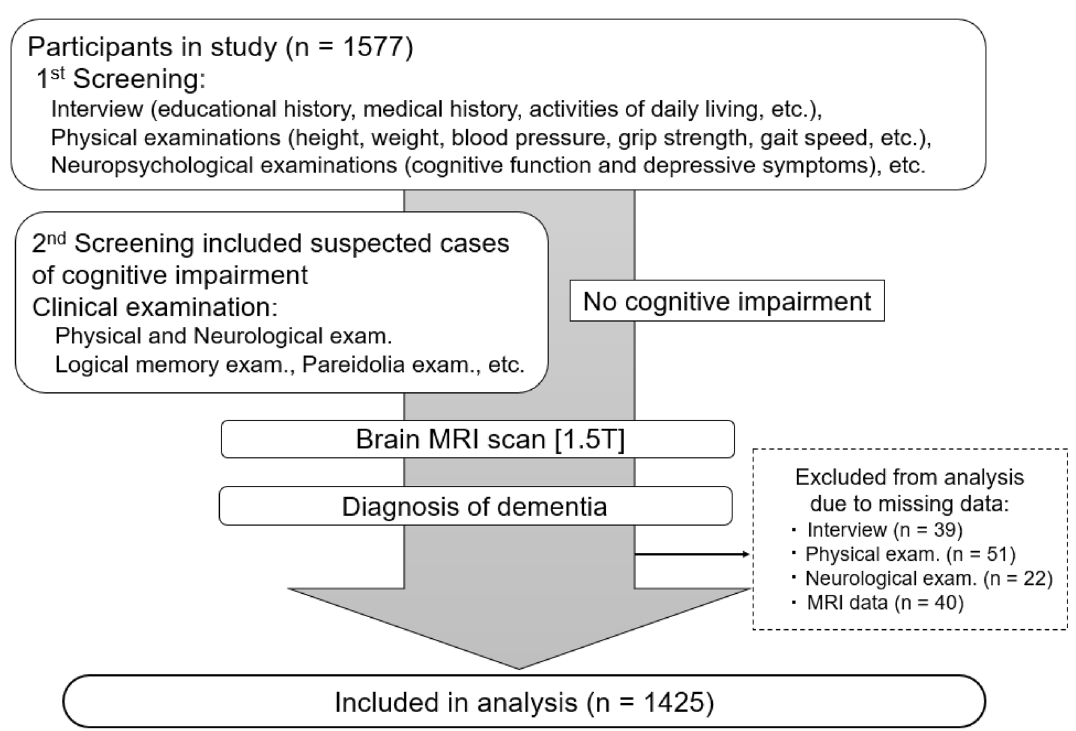
Figure 1. Flow diagram of study enrolment. The population-based cross-sectional data were obtained from one research site (Arao City, Kumamoto Prefecture) of the Japan Prospective Studies Collaboration for Aging and Dementia (JPSC-AD). A two-step screening process was then conducted to identify participants with physical frailty, mild cognitive impairment, concomitant physical frailty and mild cognitive impairment (“cognitive frailty”), and normal cognitive and physical functions. Participants diagnosed with dementia were excluded. MRI magnetic resonance imaging. No cognitive impairment Mild cognitive impairment Dementia